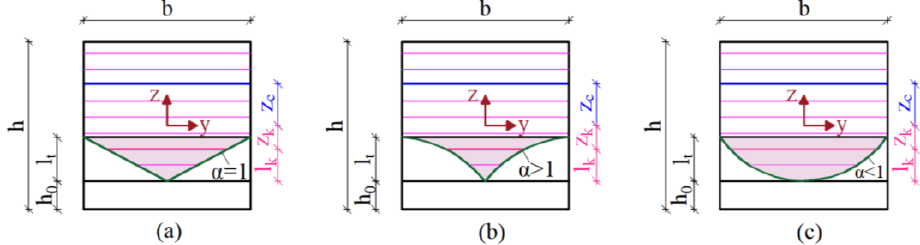
Figure 3. Notched cross-section ( a ) and diagram of normal strain ( b ).